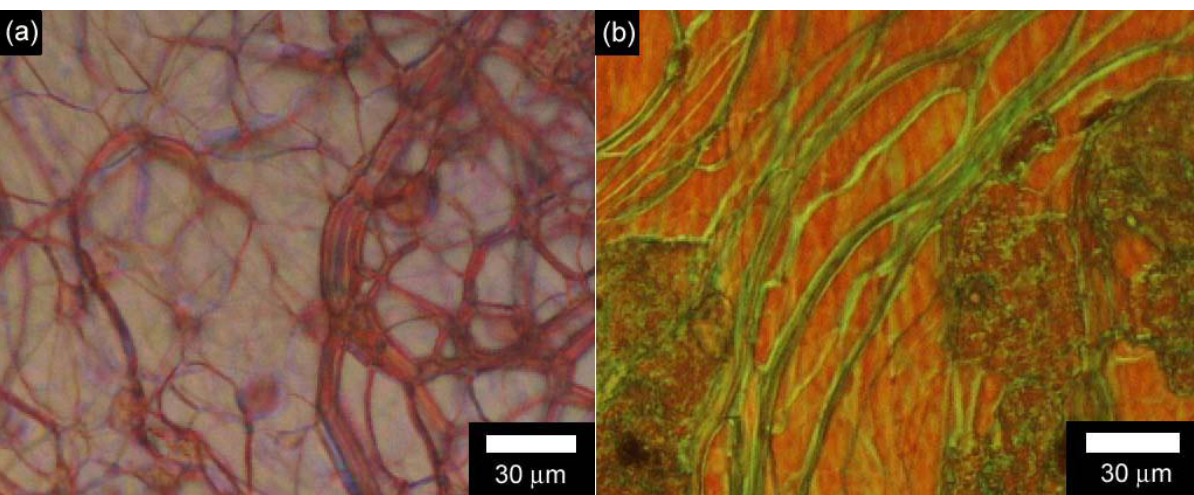
Figure 7. POM images of the reaction mixture of P2LC before polymerization (a) and P2LC after polymerization (b)